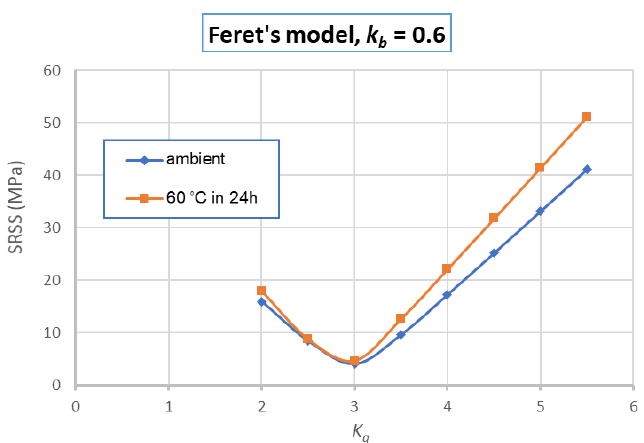
Figure 20. Variation of square root of the sum of the squares (SRSS) of GRAC compressive strength (for 3, 7, 14, and 28 days) in function of K g (for k b = 0.6).